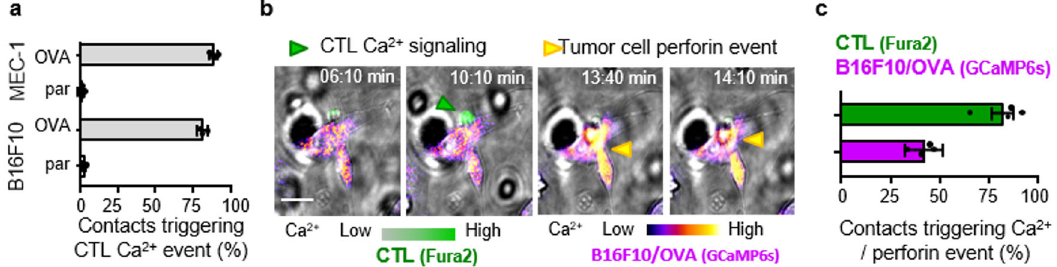
Fig. 3 Correlation between CTL Ca2 + signaling and perforin pore formation in different target cells. a Percentage of CTL contacts associated with Ca 2 + events in OVA-expressing target cells (OVA) compared to OVA-negative parental (par) cells. Data show the means ± SD from three independent experiments. b Image sequence of Fura2-labeled OT1 CTL during contact with GCaMP6s-expressing B16F10/OVA cell. Arrowheads: green, Fura2-positive event; yellow, GCaMP6s-positive event. Scale bar, 10 μ m. c Percentage of contacts triggering Ca 2 + events in OT1 CTL or B16F10/OVA target cells, respectively. Quanti fi cation (means and SD) was performed by manual analysis from 78 contacts pooled from N = 4 independent experiments. Source data are provided as a Source Data fi